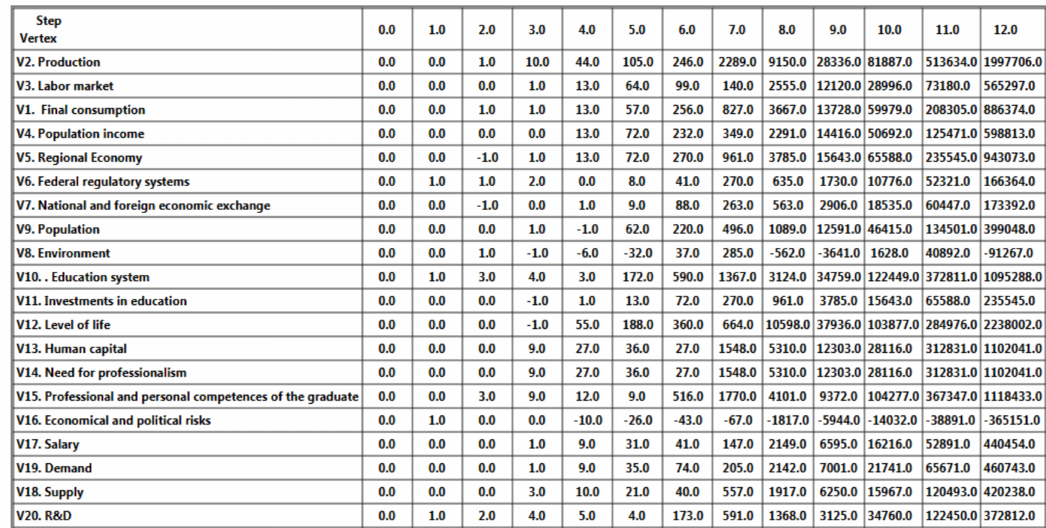
Figure 16. Scenario "Improving the conditions of higher education and economical and political risks increasing, while federal regulatory systems and R&D reacting" disturbing momentum q6 = + 1, q10 = + 1 and q16 = + 1, q20 =+ 1 (fragment from the computer data processing results on the program